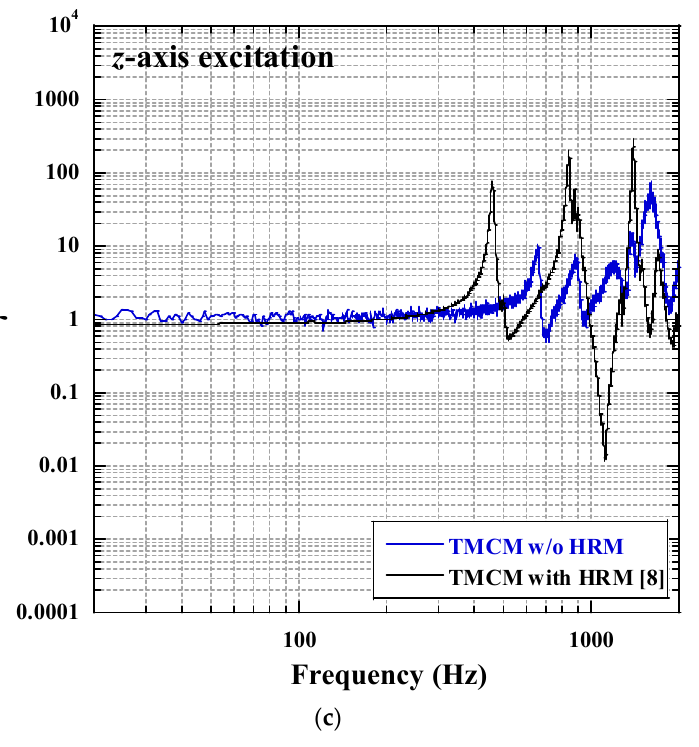
Figure 8. Comparison results of random vibration tests for TMCM with HRM [8] and the TMCM without the HRM proposed in this study ( a ) in x ‐ , ( b ) y ‐ , and ( c ) in z ‐ axis.